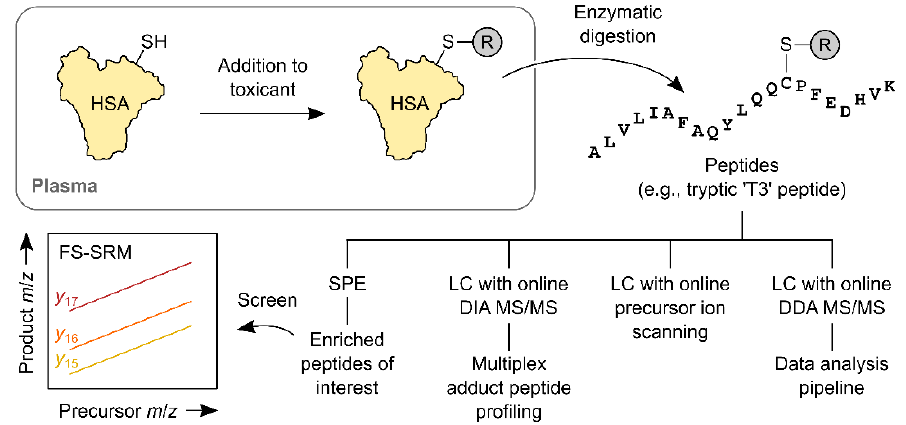
Figure 2. Main steps of published HSA Cys-34 adductomic workflows. The reaction of HSA with an electrophile in the blood plasma installs an ‘R’ group at the Cys-34 site. The HSA is isolated from plasma or serum and digested—usually with trypsin—to produce a mixture of peptides. Some of the peptides contain ‘R’ groups and others do not (the introduction of an enrichment step prior to digestion can limit the number of those that do not). Peptides are then separated chromatographically and analysed using MS / MS. One of the MS / MS methods, a stepped triple-quadrupole method termed FS-SRM, is depicted. This method monitors three variable product ions of the tryptic ‘T3’ peptide ( y 15 , y 16 and y 17 ).